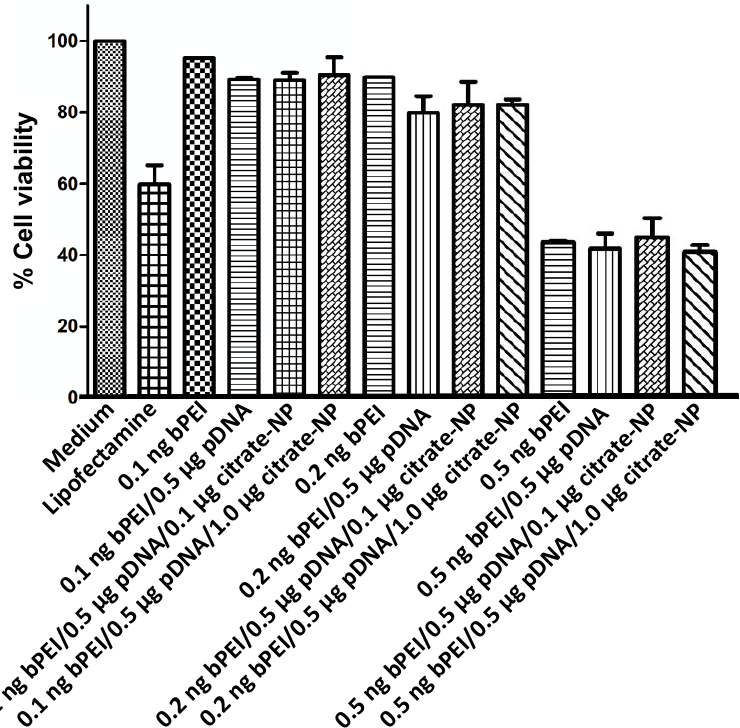
Figure 4. Cell viability of U87MG cells as determined by MTT assay 24 h after incubation with each composite for 5 h. The concentration of plasmid pEGFP-C1 pDNA of all composites was fixed at 0.5 μg/well. The amount of lipofectamine was fixed at 2.0 μg/well.